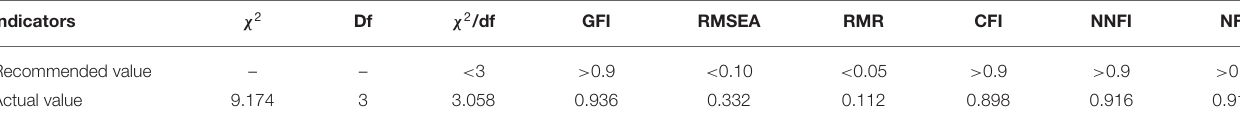
TABLE 5 | Model fit